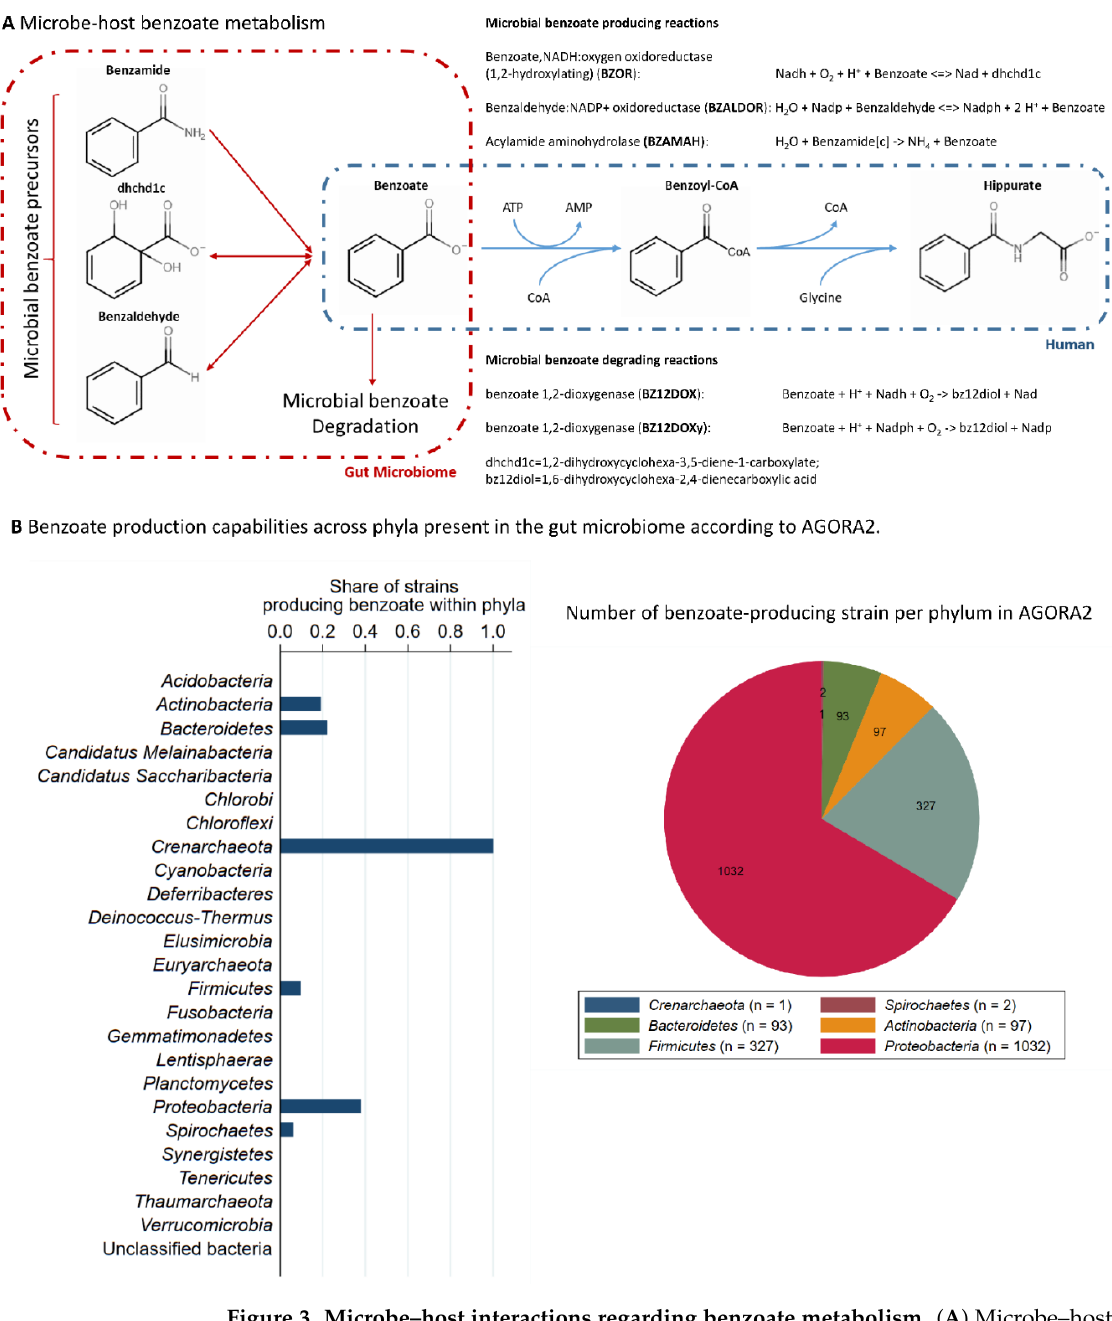
Figure 3. Microbe–host interactions regarding benzoate metabolism. ( A ) Microbe–host benzoate co-metabolism, as noted in AGORA2 and the Virtual Metabolic Human database (https://www.vmh.life, accessed on 28 January 2022). The reaction naming follows the AGORA2 nomenclature. ( B ) Benzoate production capabilities across phyla, as noted in AGORA2 as a share within phyla (left panel) and absolute number (right panel).